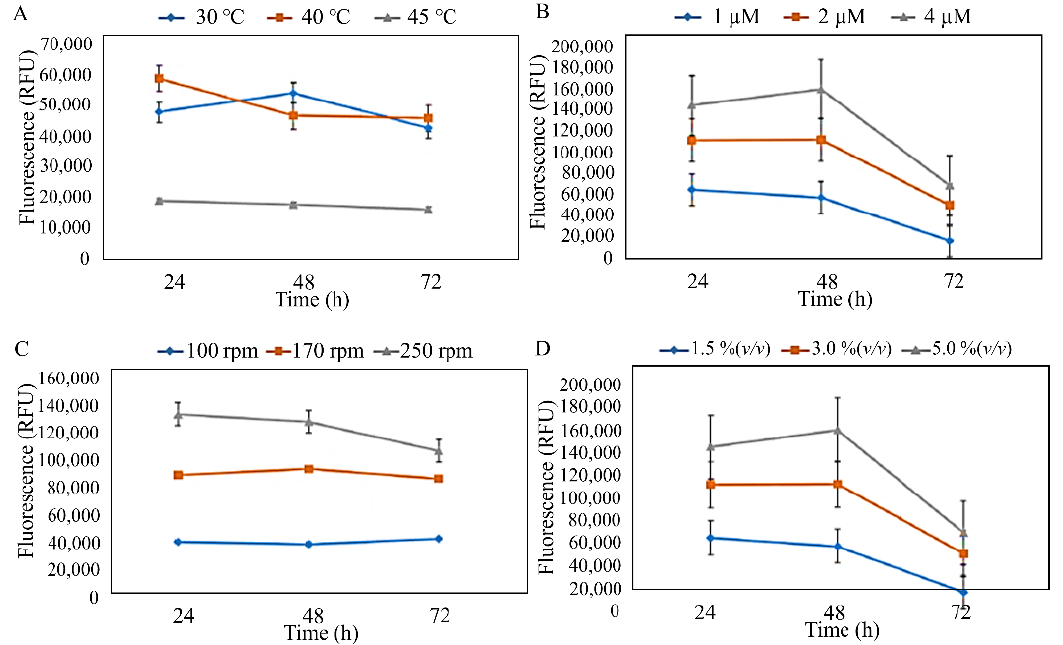
Figure 4. Identification of suitable culture parameters for PHA biosynthesis by A. faecalis UMTKB-7 cultured in glucose. ( A ). Effect of temperature on PHA production, ( B ). effect of MgSO 4 · 7H 2 O concentration on PHA production, ( C ). effect of agitation on PHA production, ( D ). effect of inoculum concentration on PHA.